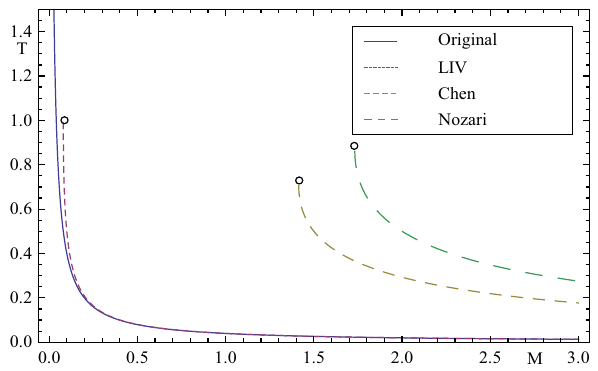
Fig. 6 The black hole’s modified temperature versus its mass when employing the GUP parameters β 0 = α = 1 and the LIV parameter ξ = 2